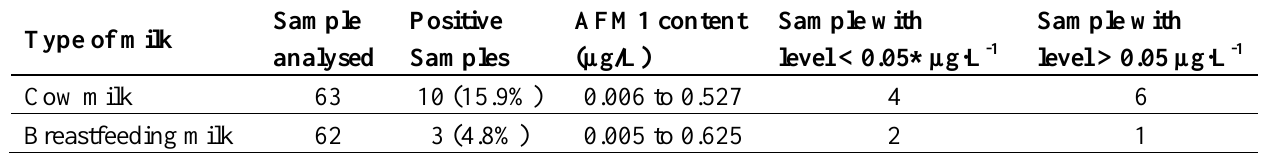
contamination of milk. 1